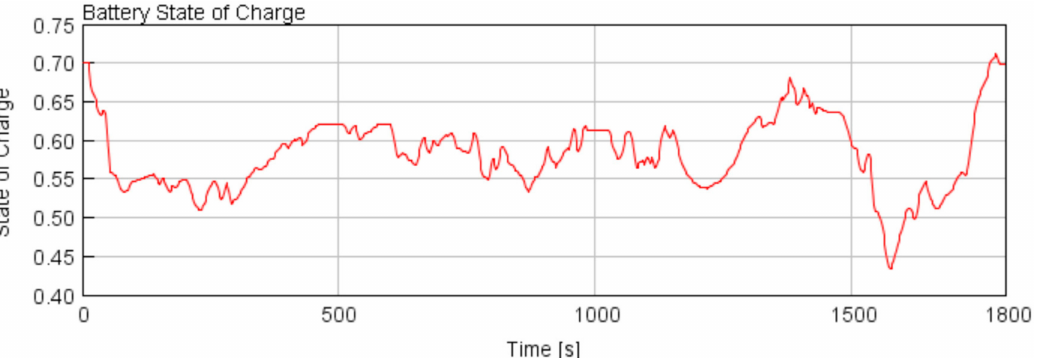
Figure 31. Battery State of Charge in